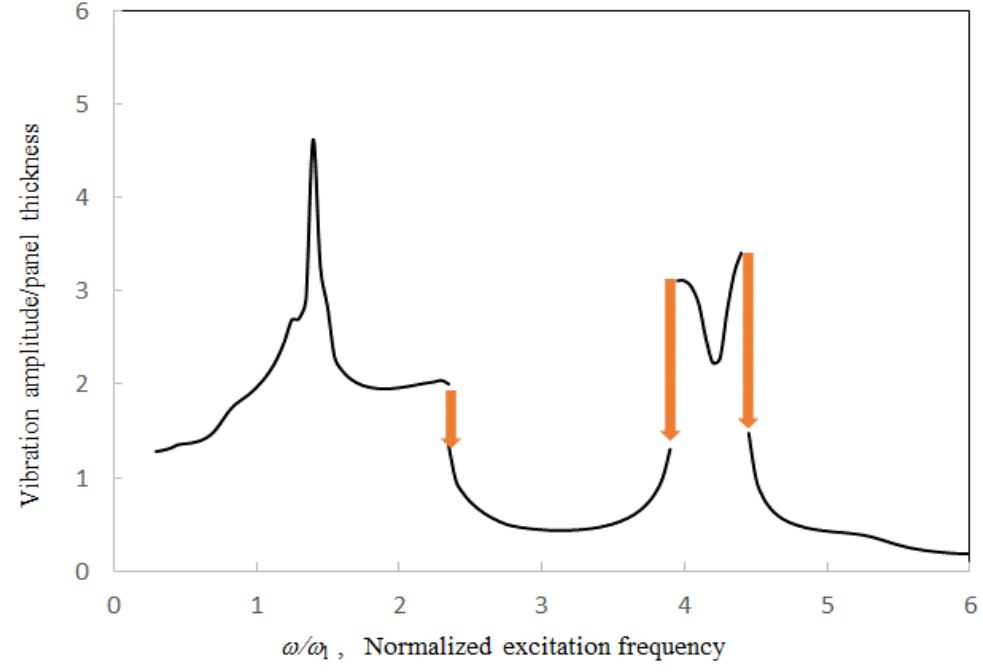
Figure 9. Vibration amplitude ratio versus normalized excitation frequency for various duct lengths (number of structural modes = 2, number of acoustic modes = 4, γ = 2, θ = 0, l = 5 a ; the orange arrows represent the “jump phenomenon”).